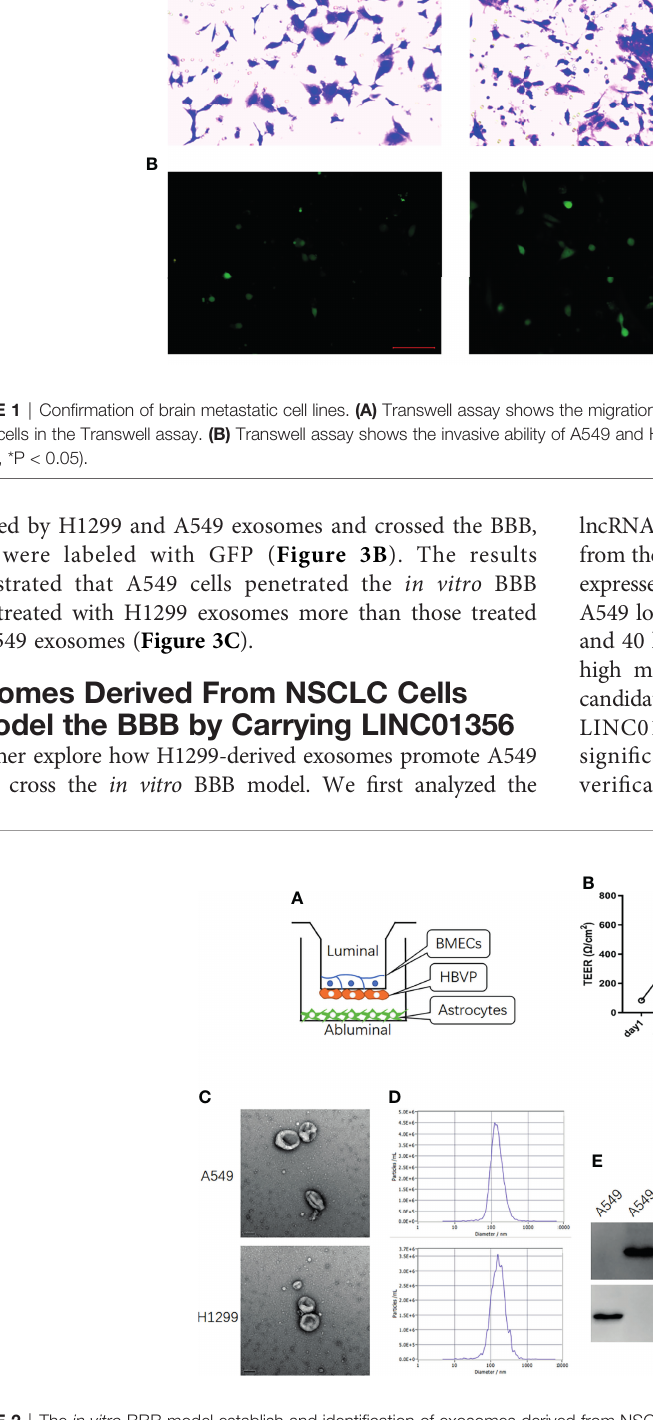
FIGURE 2 | The in vitro BBB model establish and identi fi cation of exosomes derived from NSCLC cells. (A) Schematic diagram of the in vitro BBB model, in vitro (B) The curve over time of TEER established in the in vitro BBB model. (C) TEM identi fi cation of exosomes from A549 and H1299 cells. (D) The NTA analysis of the diameter of exosomes from A549 and H1299 cells. (E) Western blot identi fi cation of the exosome marker CD63 in cells and exosomes. (F) SDS page analysis of exosomes protein